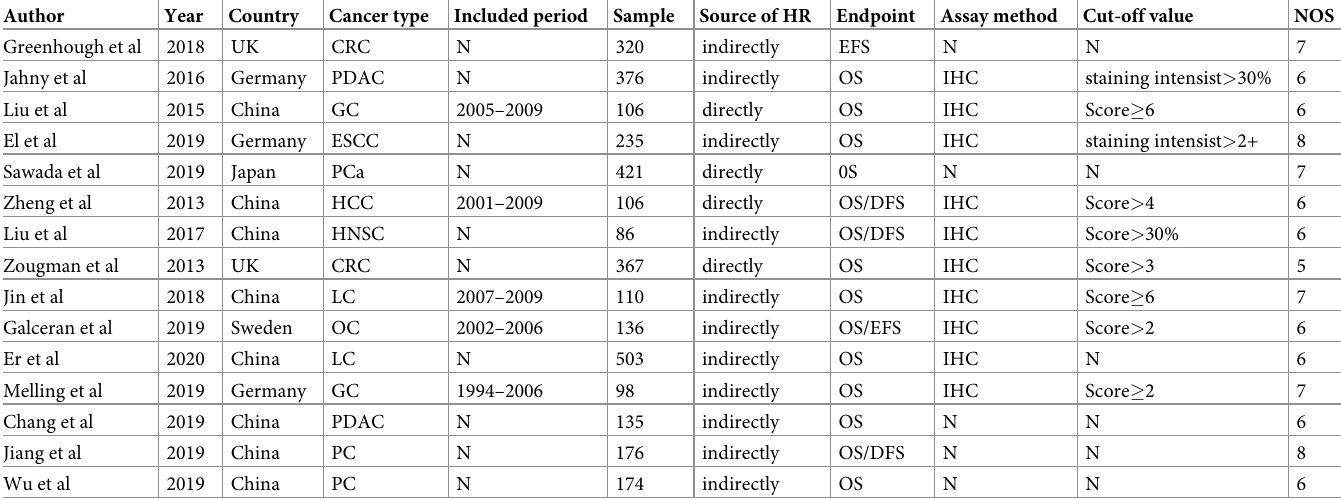
Table 1. The main characteristic of enrolled records in the